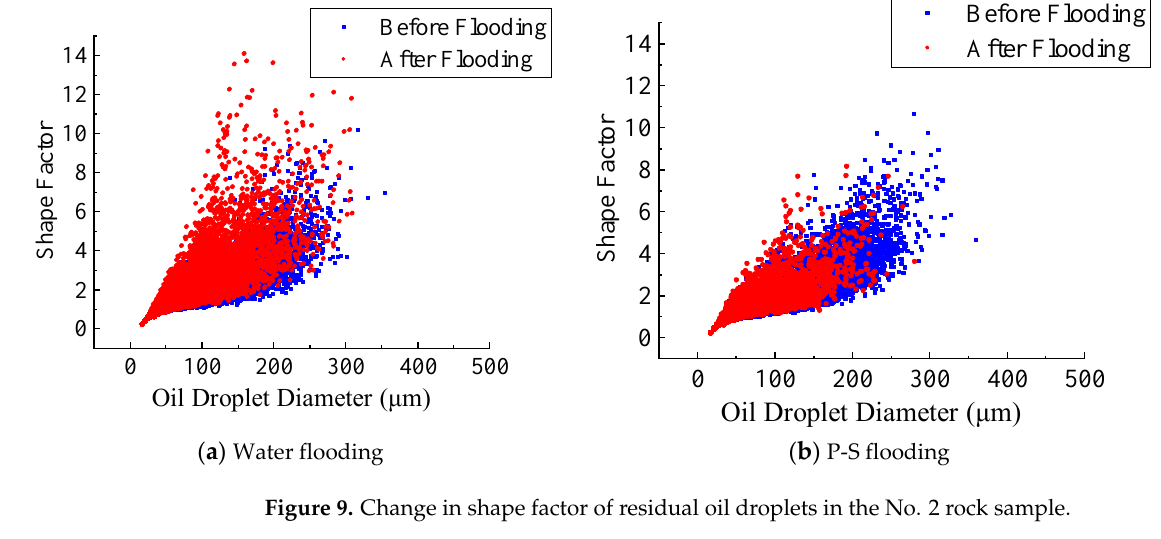
Figure 9. Change in shape factor of residual oil droplets in the No. 2 rock sample.